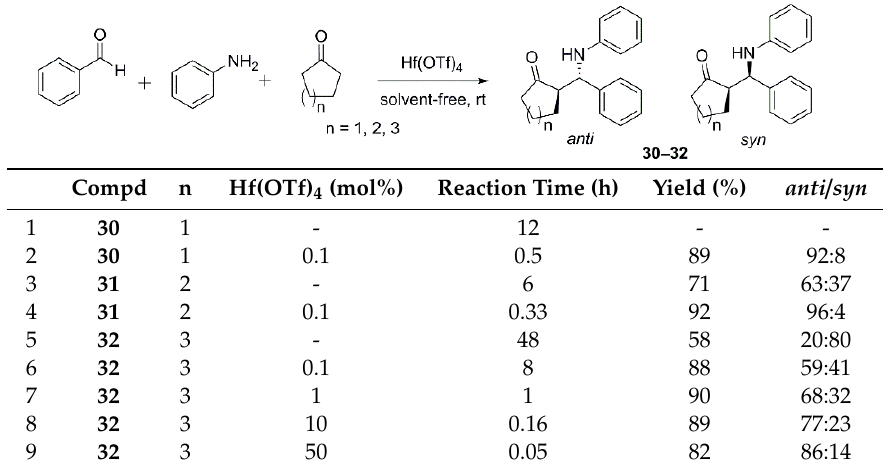
Table 4. The diastereoselectivity of Hf(OTf) 4 -catalyzed synthesis of cycloketone-derived Mannich bases 30 – 32 a .